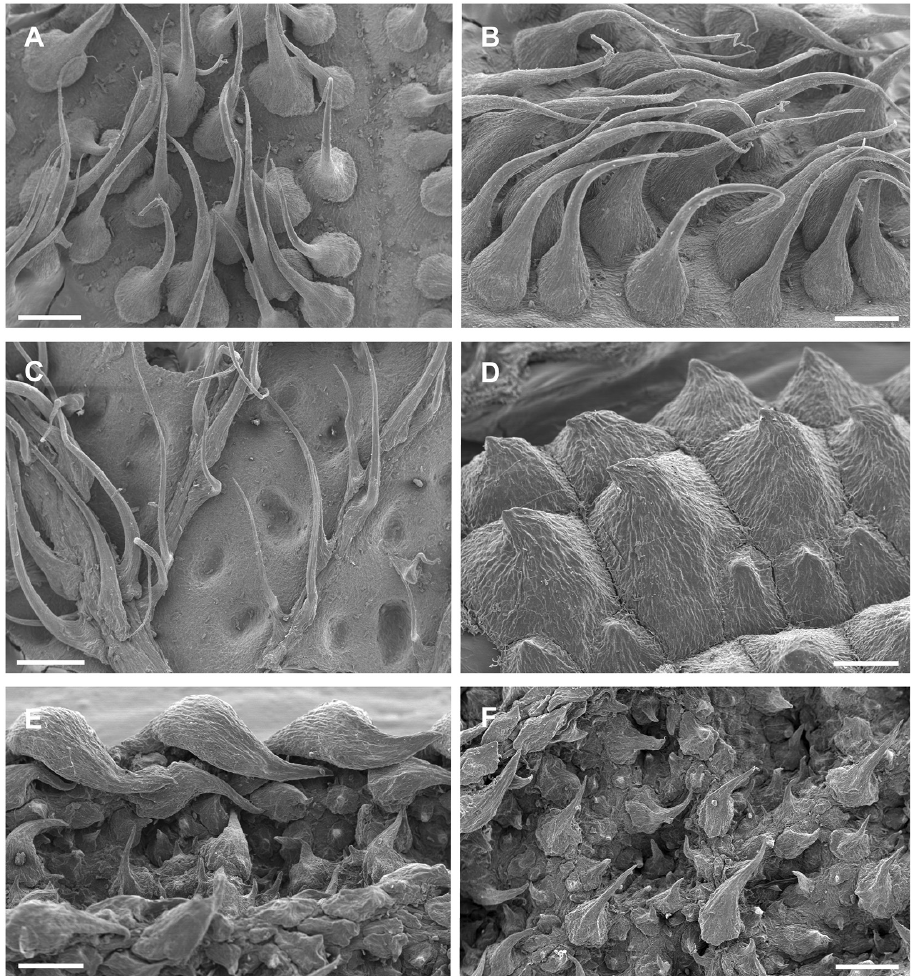
Figure 1. Photomicrographs of indumentum characters and epidermal features of members Miconia pe- dunculata ( A–C ) and M. lima ( D–F ). A–B Adaxial leaf surface of M. pedunculata (scale bar = 0.75 mm), B close-up of bulla-based hairs on adaxial leaf surface (scale bar = 0.6 mm), C abaxial leaf surface show- ing pits and strigose hairs (scale bar = 0.6 mm; all from Pimentel 806 ), D adaxial leaf surface of M. lima showing bulla-based hairs filling areoles (scale bar = 0.375 mm; all from Judd 5194 ), E abaxial leaf surface showing marginal, recurved bulla-based hairs covering dentations (scale bar = 0.375 mm), and F abaxial leaf surface showing pitting and epidermis covered in bulla-based hairs. All photos taken by G.M.